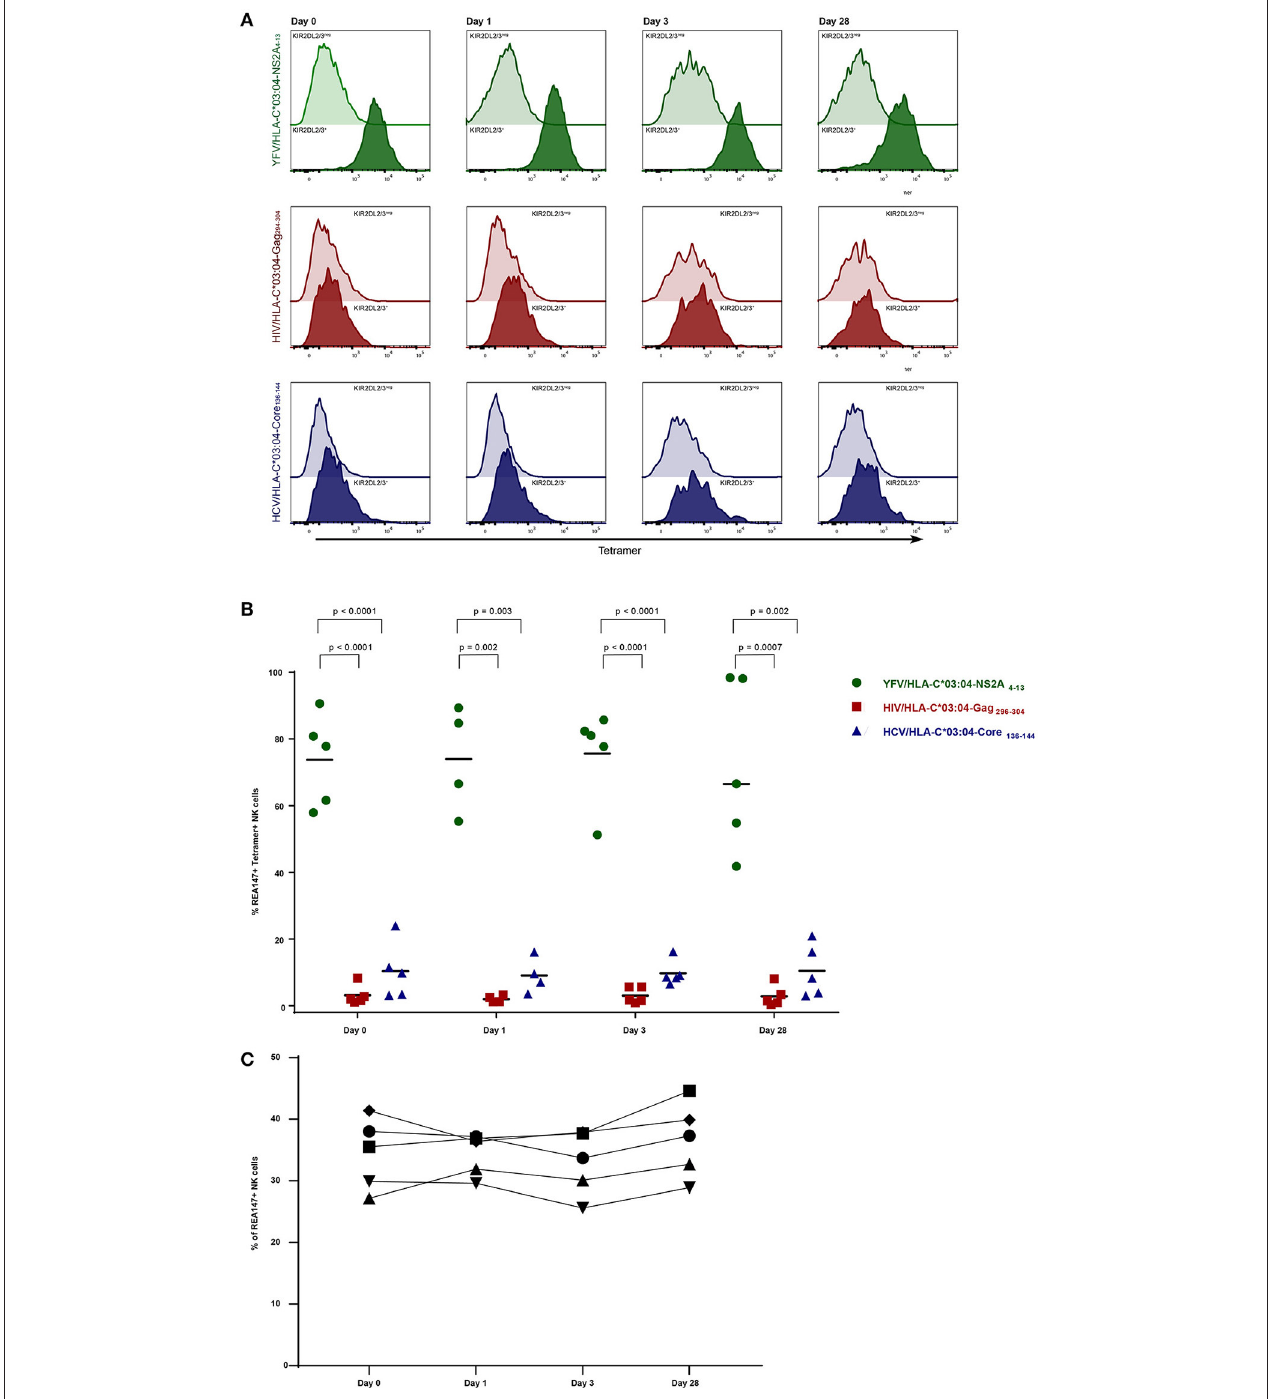
FIGURE 2 | Frequencies of KIR2DL2/3 + tetramer + NK cells in YFV vaccinees over time. Staining with YFV/HLA-C*03:04-NS2A 4 − 13 -, HIV/HLA-C*03:04- Gag 296 − 304 - and HCV/HLA-C*03:04-Core 136 − 144 - tetramers is depicted in green, red and blue, respectively. (A) Histograms demonstrating representative tetramer-staining of KIR2DL2/3 + (clone REA147 + ) NK cells (tinted) and KIR2DL2/3 neg NK cells (transparent) derived from one YFV vaccine recipient at 0, 1, 3, and day 28 after vaccination. (B) Scatter Plot of frequencies of tetramer + KIR2DL2/3 + (clone REA147 + ) NK cells in the 5 YFV vaccine recipients stained with the respective tetramers at 0, 1, 3, and day 28. Black bar represents median of each group. (C) Frequencies of total KIR2DL2/3 + (clone REA147 + ) NK cells at 0, 1, 3, and day 28 after vaccination. Freshly isolated PBMCs were used for all experiments. P -values were calculated using Mann-Whitney test.